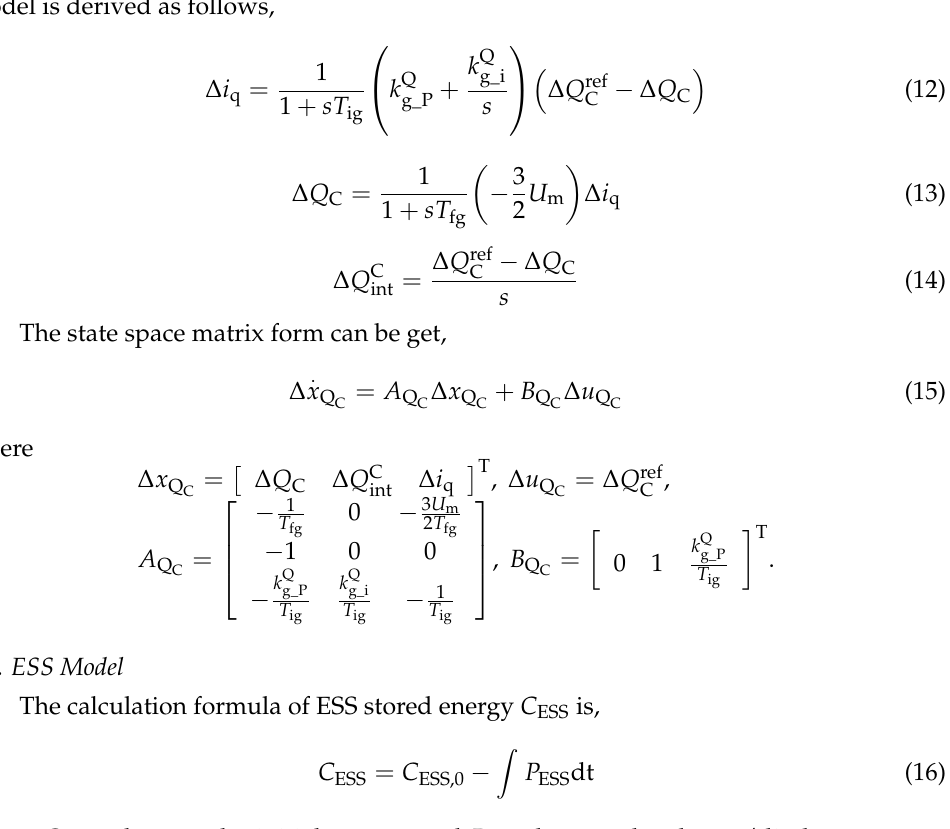
denotes ESS filter time constant. Superscript ‘*’ indicates reference